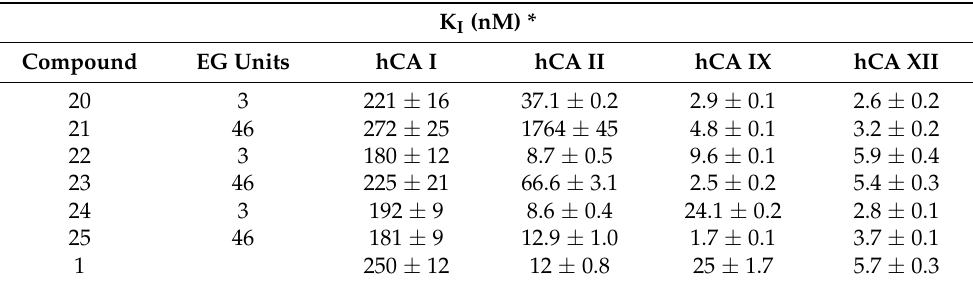
Table 1. Inhibition data of human CA cytosolic isoforms hCA I and II and membrane-bound CA IX and XII with oligo/polyEG derivatives 20–25 and the standard sulfonamide inhibitor acetazolamide 1 by a stopped flow CO 2 hydrase assay